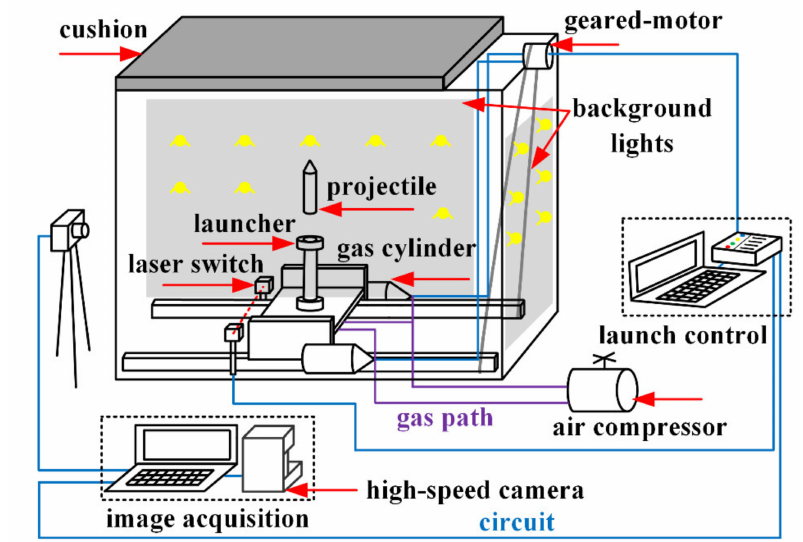
Figure 1. Major components of the underwater launching